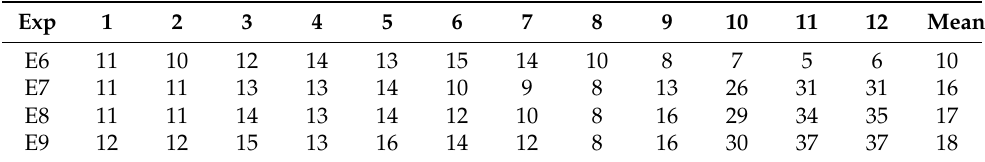
Figure 8. The peaks of surge levels of E1, E3, E6, and observations at the YingKou, LongKou, and YanTai stations during Typhoon 7008. YanTai stations during Typhoon 7008. Table 6. Root mean square errors between the simulation and observation of storm surge levels in every period of Typhoon 7008 (unit: cm).